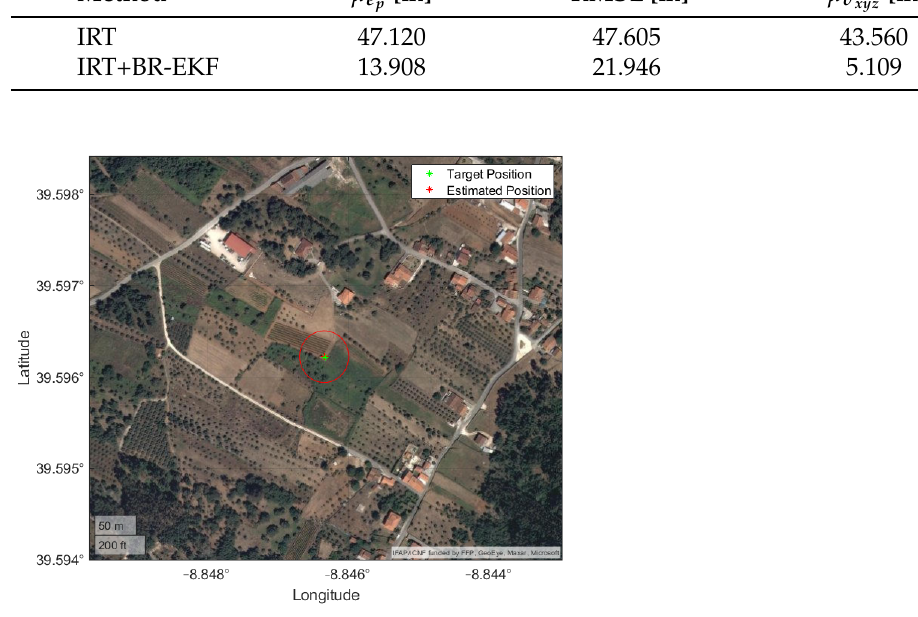
Figure 16. Mean position and uncertainty from aerial perspective simulation displayed on a satellite view of the